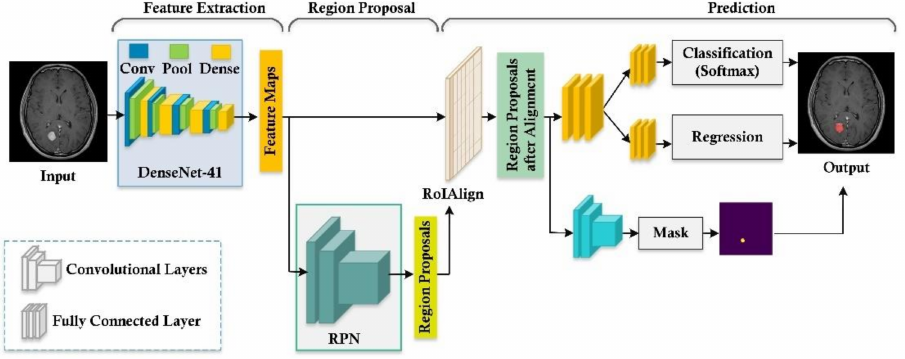
Figure 3. The structure of the proposed